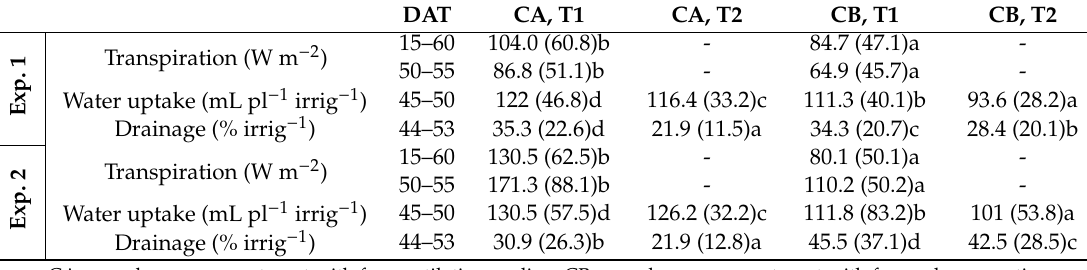
Table 3. Mean values ( ± standard deviation) of plant transpiration measured by weighing lysimeters, water uptake estimated with the water balance method and drainage for Exp. 1 (autumn–winter crop) and Exp. 2 (spring crop). DAT